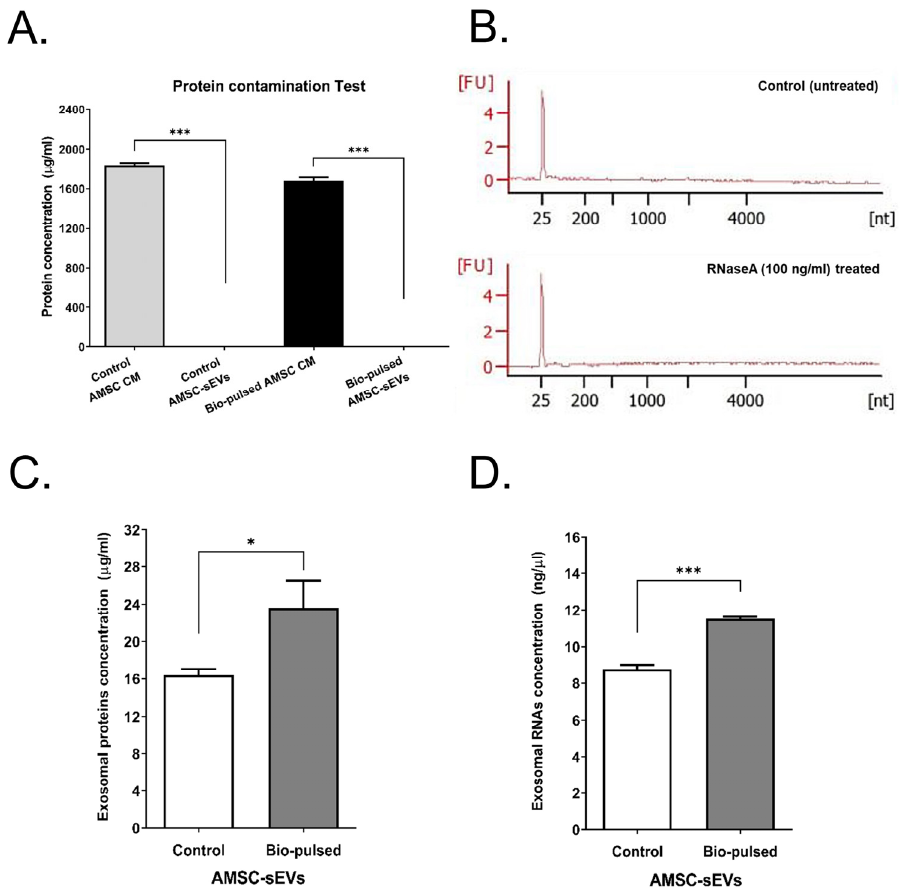
Figure 3. The quality of bio-pulsed AMSC-sEVs. ( A ) Residual proteins contained in lyophilized powder (outside the exosomes) were almost removed through purification and isolation. (n = 3, data are expressed as the mean ± standard deviation; *** p < 0.001, compared with the control AMSC CM or bio-pulsed AMSC CM). ( B ) Small RNA profiles extracted from bio-pulsed AMSC-sEVs and after RNaseA (100 ng/mL) treatment. RNA was extracted from samples and run on a Small RNA Bioanalyzer assay. The concentrations of exosomal proteins ( C ) and RNAs ( D ) were analyzed after lysing and extracting from both the lyophilized sEVs. (n = 3, data are expressed as the mean ± standard deviation; * p < 0.05, *** p < 0.001, compared with the control AMSC-sEVs).